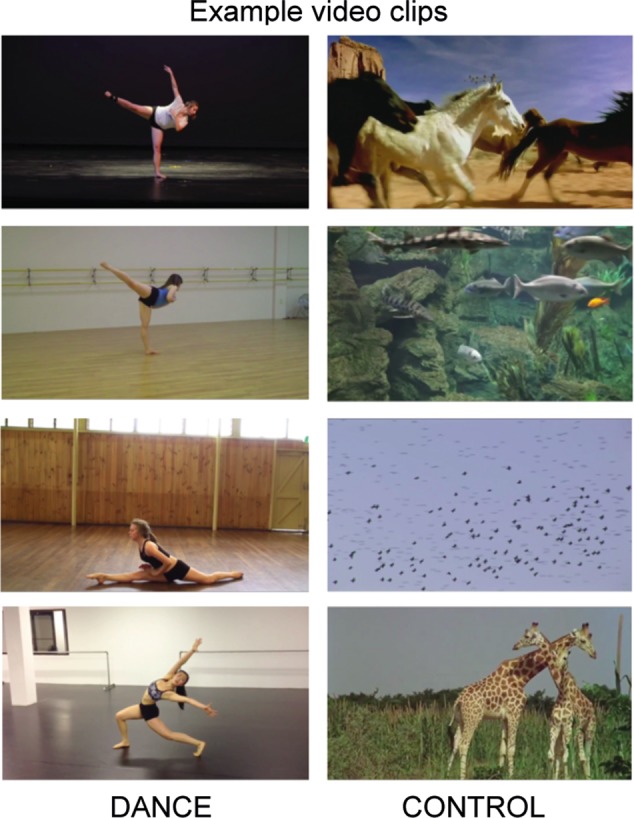
Examples of Dance and Control videoclips used in fMRI task for mapping the action observation network (AON) of dance stimuli.